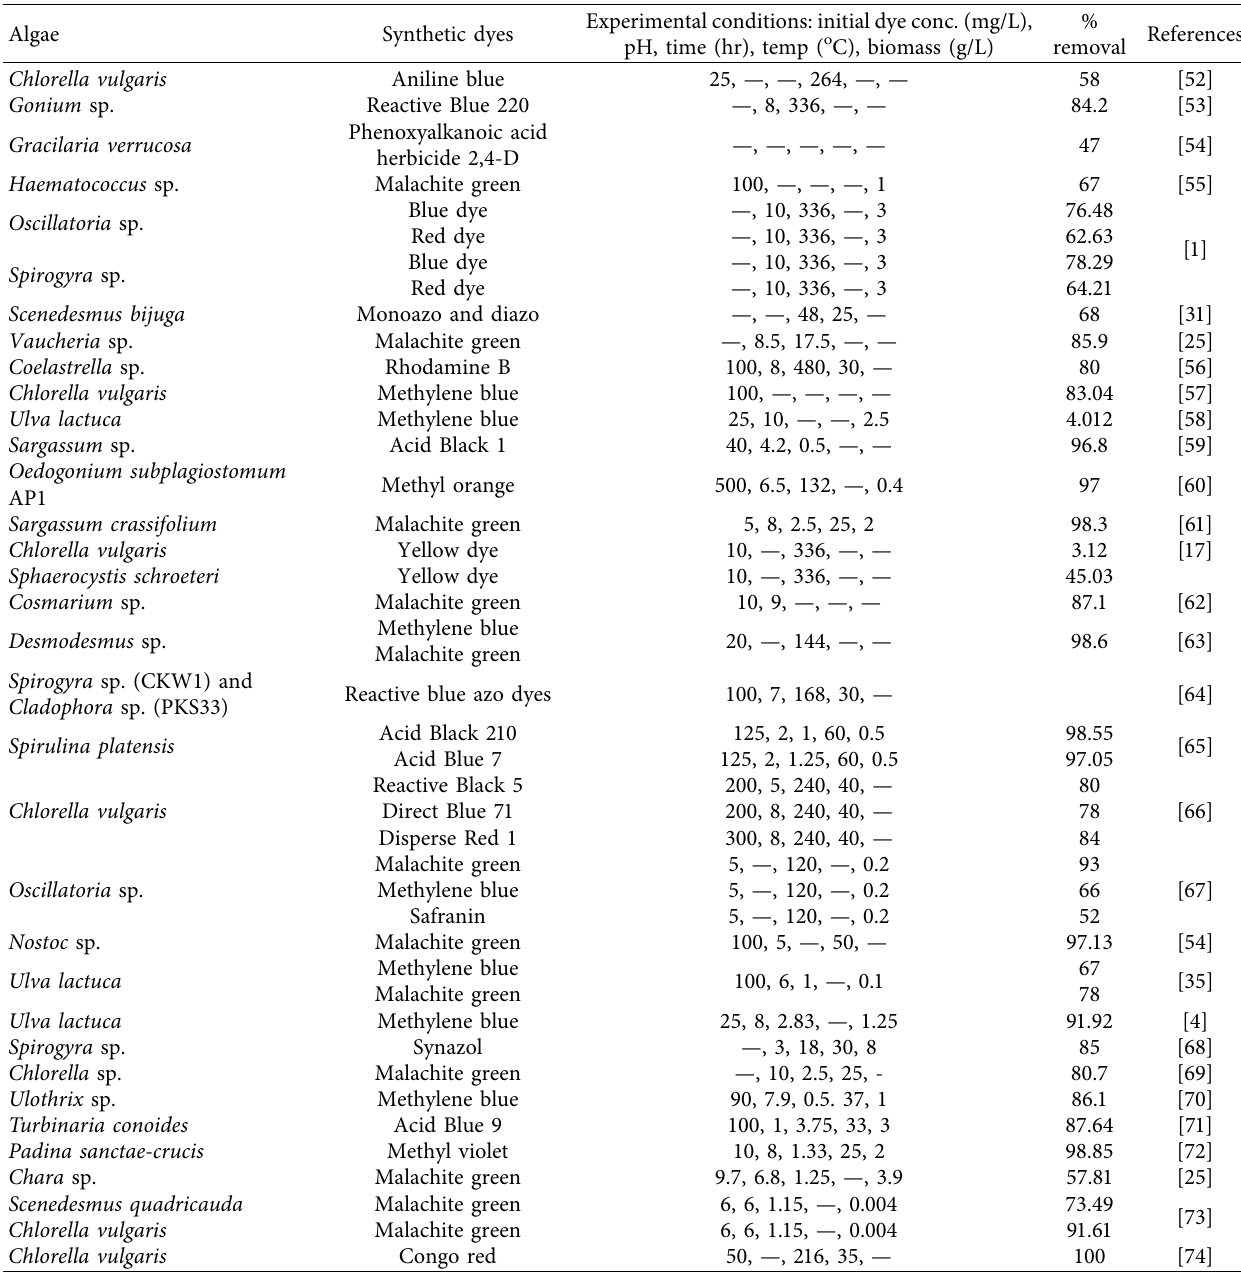
Table 3: Abatement of various synthetic dyes by